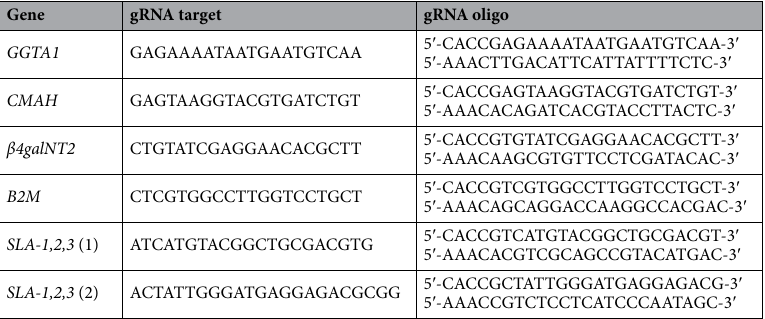
Table 1. Sequences of gRNA target and gRNA oligos.